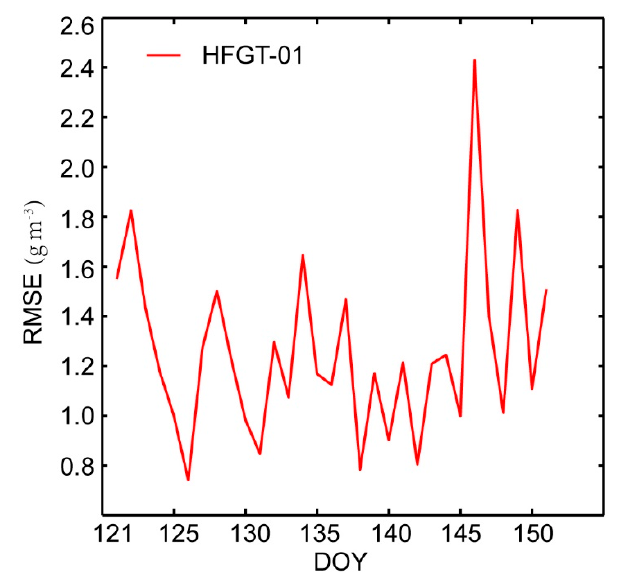
Figure 9. RMSE (red line) of HFGT-01 at Universal Time Coordinated (UTC) 12 in the 31-day period; HKKP’s radiosonde data were used as the reference.